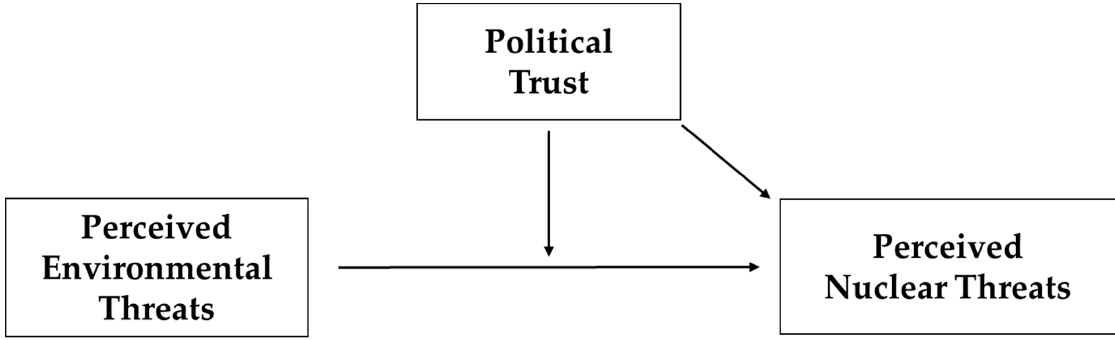
Figure 1. Conceptual Framework.